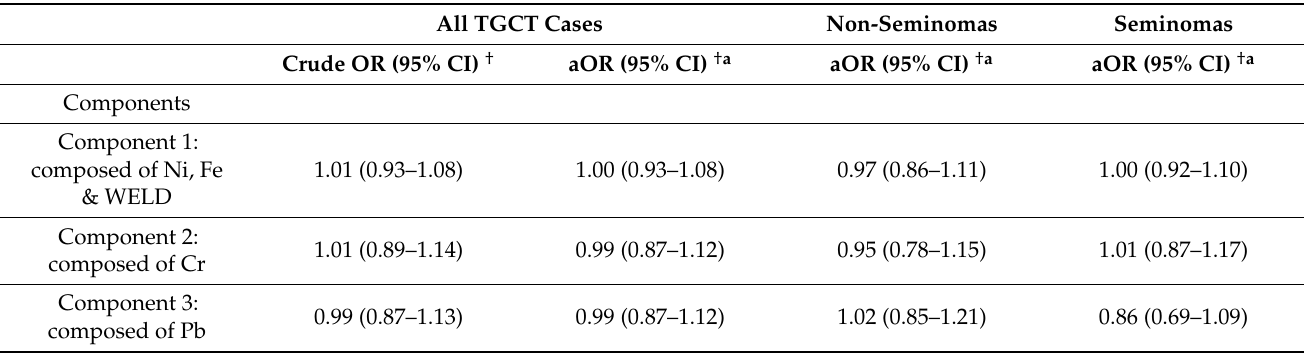
Table 4. Odds ratios (ORs) † and 95% confidence intervals (95% CIs) of TGCT using principal component analysis of metals and welding fumes, TESTIS study, 2015–2018, France (N =